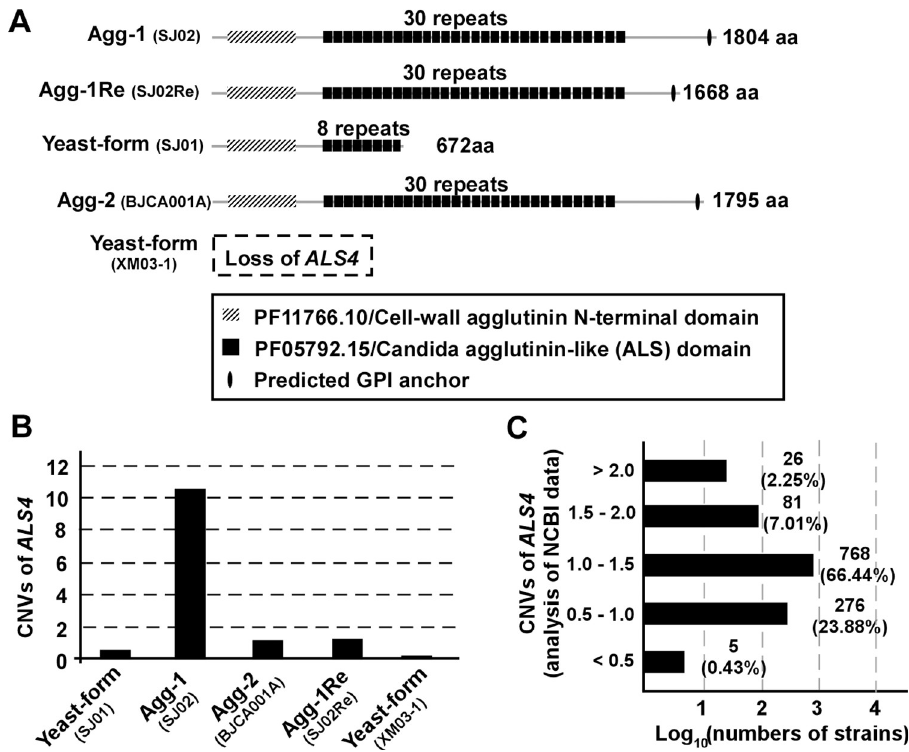
Fig 6. Protein sequence variations and CNVs of ALS4 of C . auris clinical isolates. (A) Schematic diagrams of the predicted Als4 proteins of the nonaggregative/yeast-form (SJ01), Agg-1 (SJ02), Agg-2 (BJCA001A), Agg-1Re (SJ02Re), and nonaggregative/yeast-form XM03-1 strains. The nonaggregative/yeast-form strain (SJ01) carries a truncated ALS4 gene, which encodes a protein containing only 8 repeats of the Als domain. The Xiamen isolate XM03-1 is a natural strain missing the ALS4 gene. (B) Copy number variations (CNVs) of ALS4 of the yeast-form (SJ01), Agg-1 (SJ02), Agg-2 (BJCA001A), Agg-1Re (SJ02Re), and yeast-form (XM03-1) strains. Both the nonaggregative/yeast-form (SJ01) and “returned” nonaggregative/yeast-form (SJ02Re) strains carry a single copy of the ALS4 gene, whereas the aggregative-form strain (SJ02) carries 10 copies of the ALS4 gene. (C) CNV analyses of ALS4 for 1156 C . auris strains (genomic sequences were retrieved from the NCBI